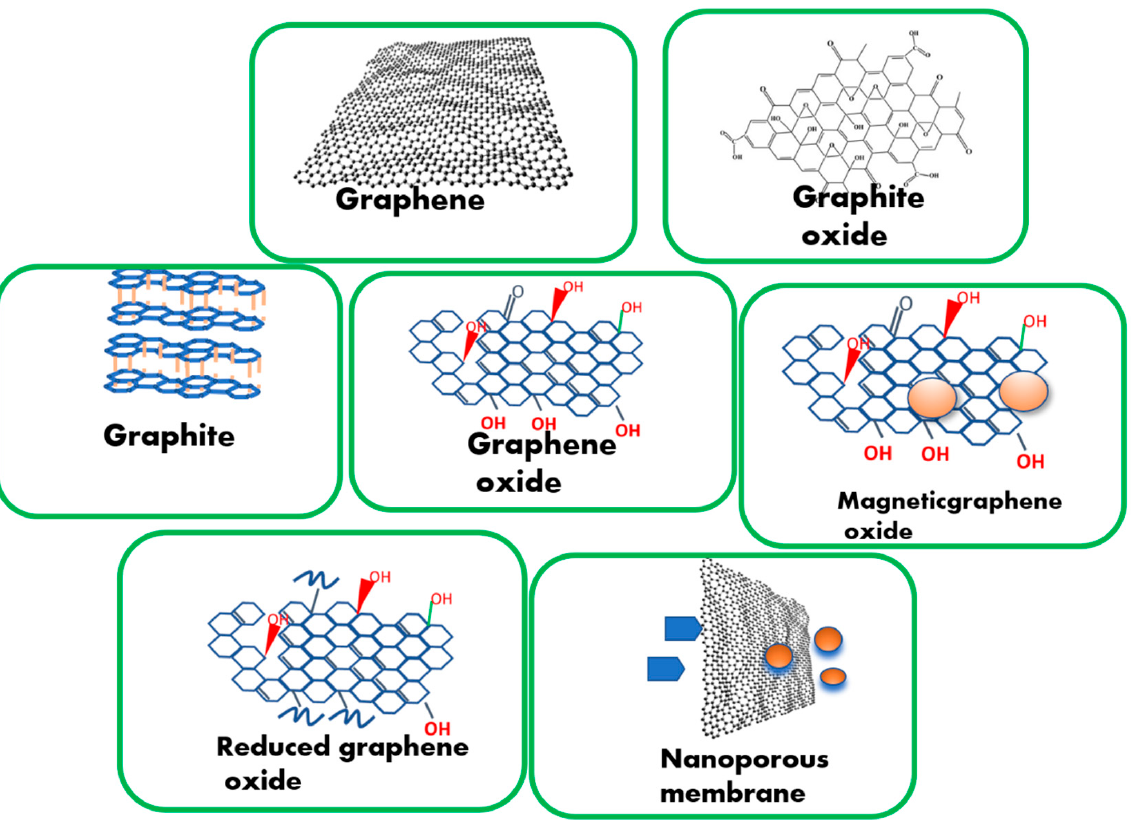
Figure 4. Schematic representation of graphene-based materials (Gr2Ms) [66].